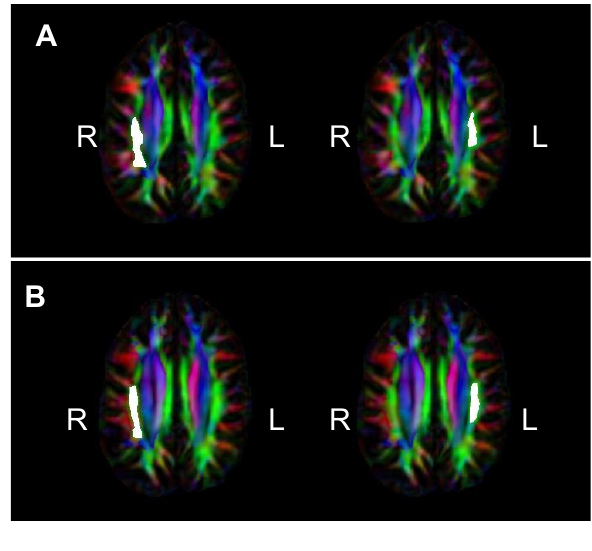
Figure 2. Superior longitudinal fasciculus (SLF) regions of interest (ROIs) selected in Reproducible Objective Quantification Scheme (ROQS), shown on fractional anisotropy (FA) map of representative Williams syndrome participant. White matter fiber tract directionality is given by the FA map: red (right-left), green (anterior-posterior), blue (superior-inferior). ( A ) Right and left superior SLF ROIs; ( B ) Right and left inferior SLF